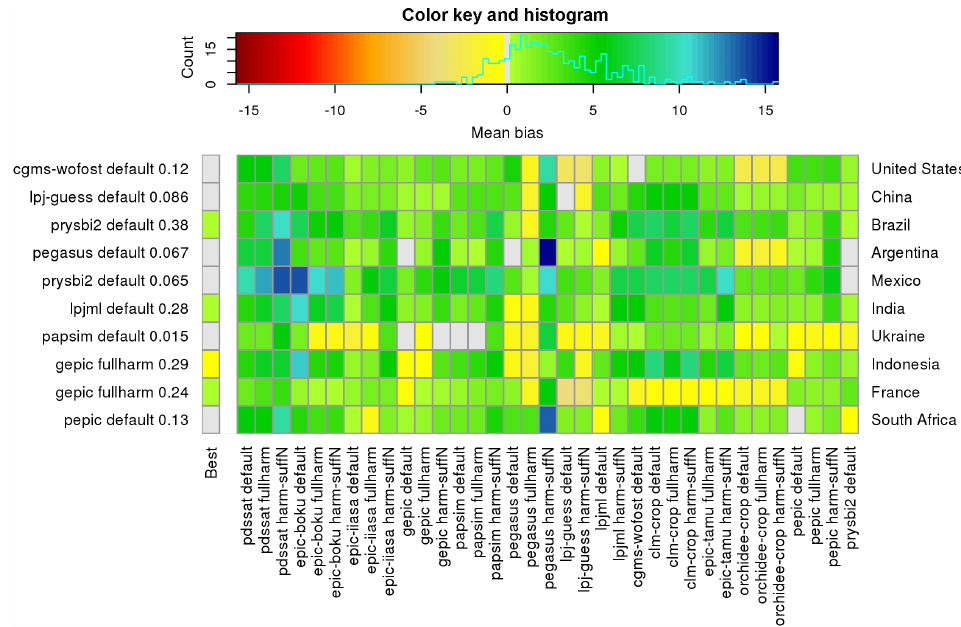
Figure 7. As Fig. 6, but for mean bias (tha − 1 ) of simulated yields for the top-10 producer countries for